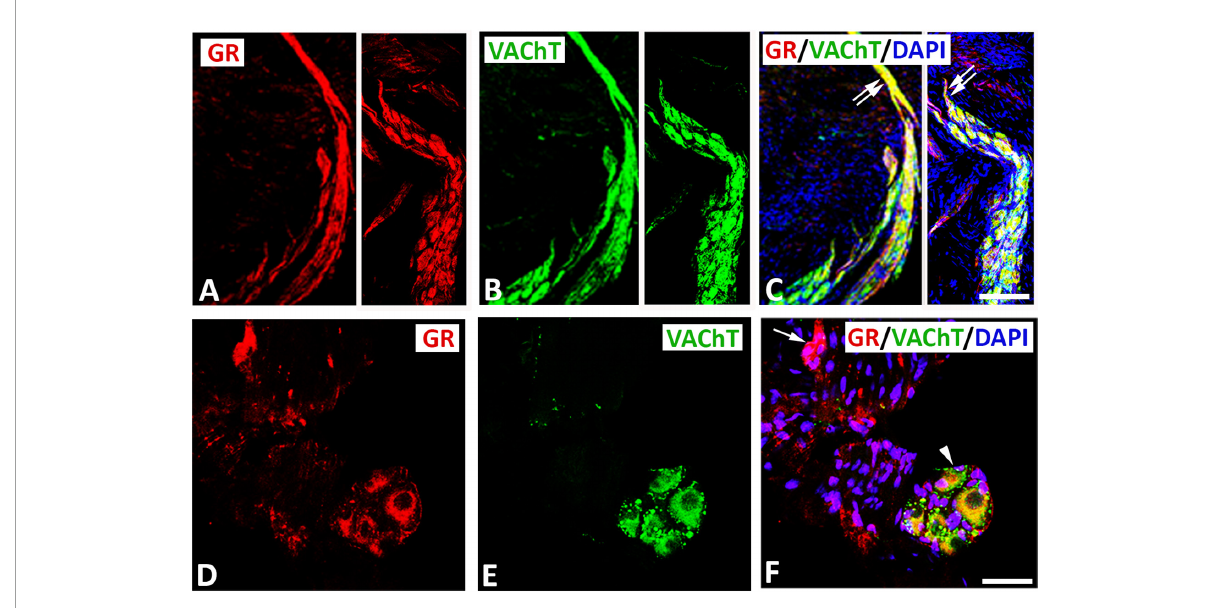
FIGURE1 Confocal microscopy of GR (A,D) ( red fluorescence ) and parasympathetic neuronal marker VAChT (B,F) ( green fluorescence ) double immunofluorescence in intracardiac ganglia (A–F) . (A–C) ( right and left ) Show GR co-expressed with VAChT immunoreactivity ( yellow fluorescence ) in a cluster of neuronal soma. Note, VAChT-immmunoreactive bundles of nerve fibers extending from ganglion neuronal somata. (D–F) Show large size principal neuronal somata in rat atria coexpressing GR and VAChT (arrowhead) in close proximity with a cluster of 5 small size neurons (as indicated with five nuclei) which express GR only (arrow) and lack VAChT immunoresctivity. (D,F) Show DAPI nuclear staining ( bright blue ). Bar: (A–C) = 40 µ m; (D–F) = 120 µ